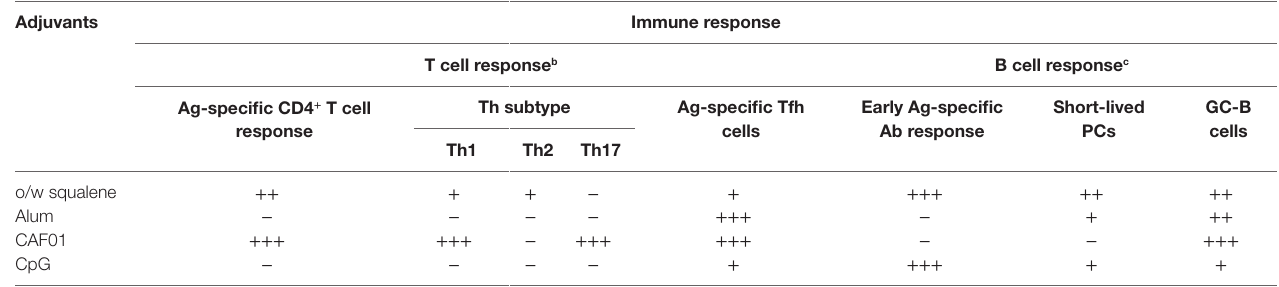
TaBle 2 | evaluation of early adjuvant activity after primary immunization. a